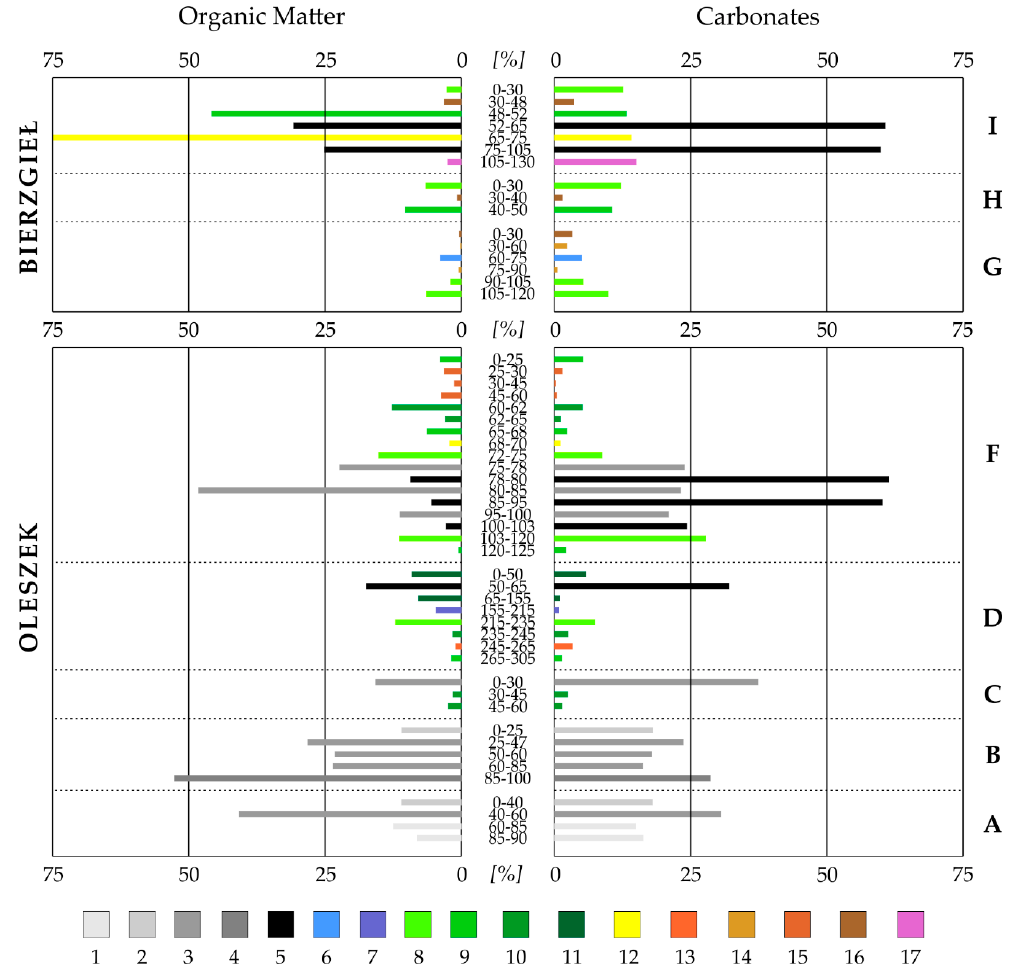
Figure 5. Concentration (%) of organic matter and carbonates in selected depths of sediments of Bierzgie ł and Oleszek mill ponds. Notation: A–I—investigated profiles like those on Figures 3 and 4; sediment classifications: 1—silty-clay gyttja, 2—silty gyttja, 3—silty-limestone gyttja,